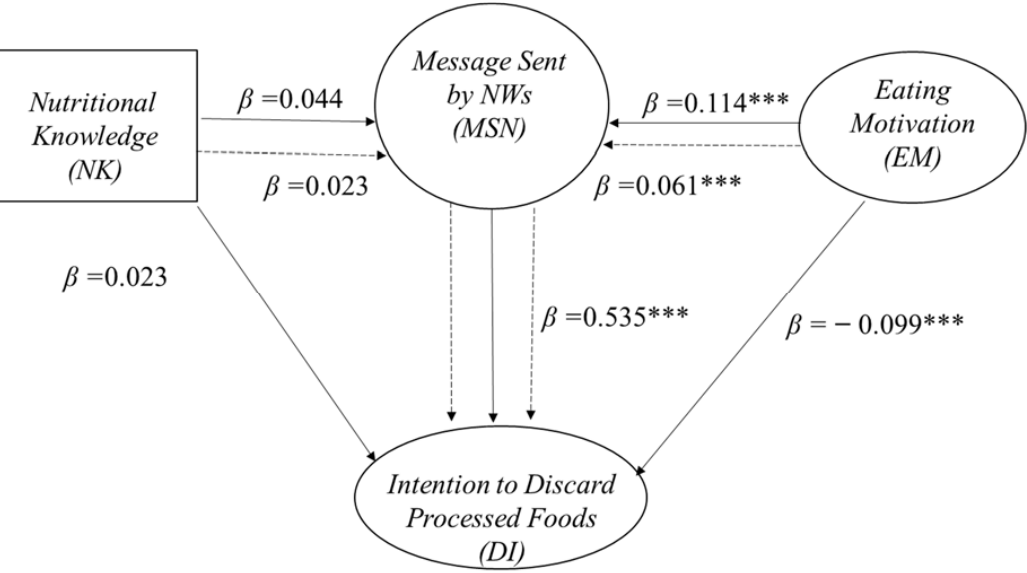
Figure 2. Results of testing the reduced model: standardized path coefficients ( β ). Note: *, **, *** significant at levels 0.10, 0.05, and 0.01, respectively.